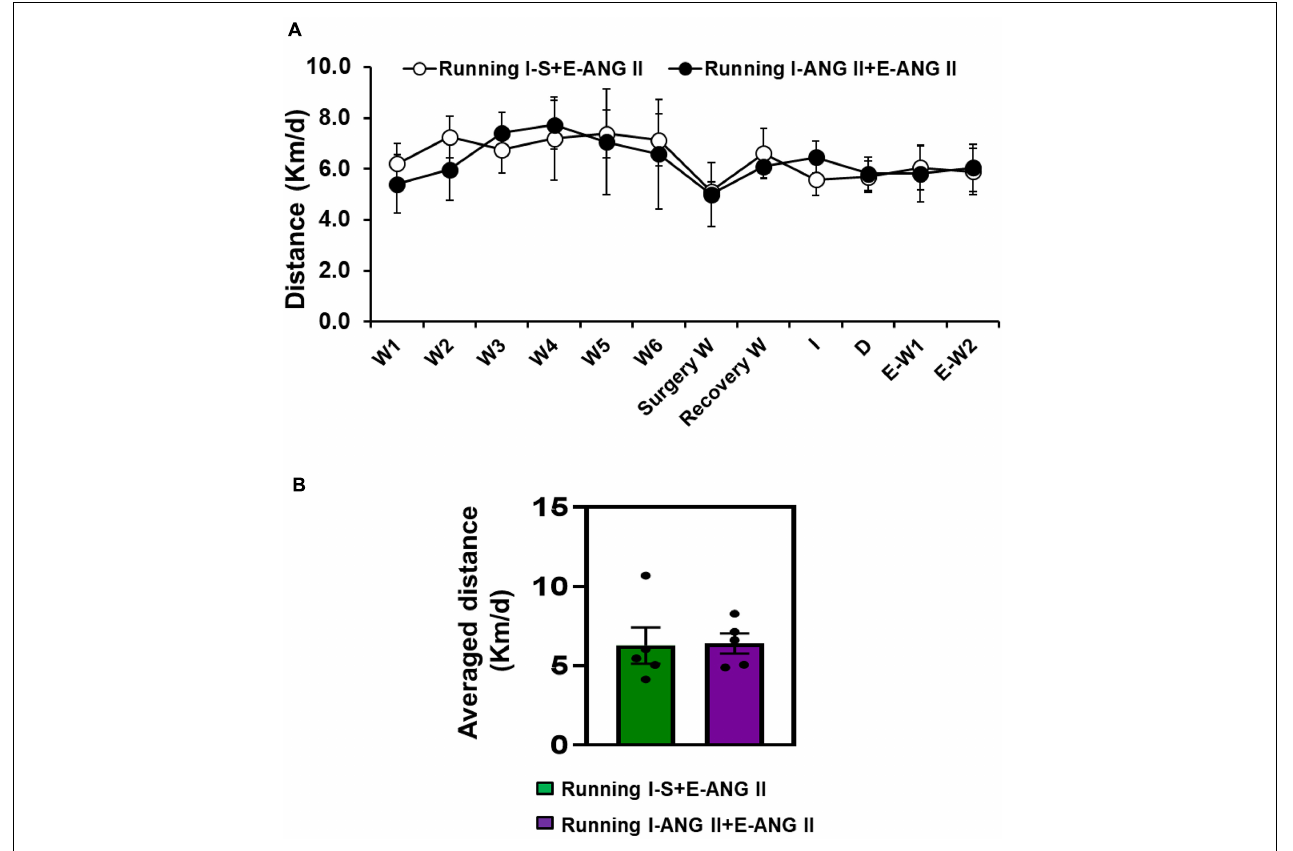
FIGURE 2 | The daily (A) and averaged (B) running distances during 12 weeks of voluntary exercise (Running) in rats with Induction-Delay-Expression (I-D-E)